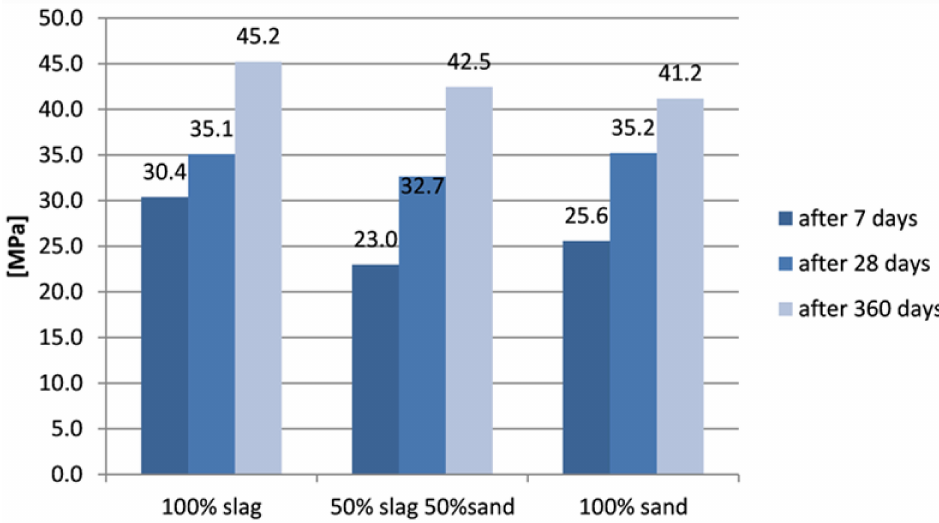
Figure 7. Compressive strength of samples with zeolite.